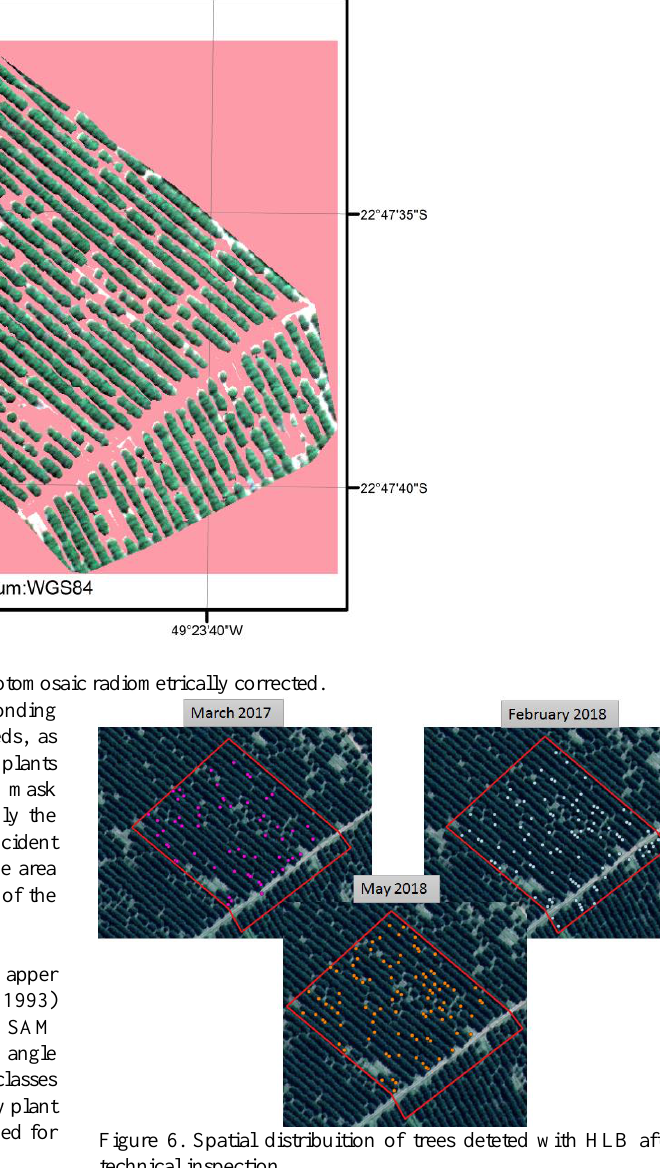
Figure 6. Spatial distribuition of trees deteted with HLB after technical inspection.